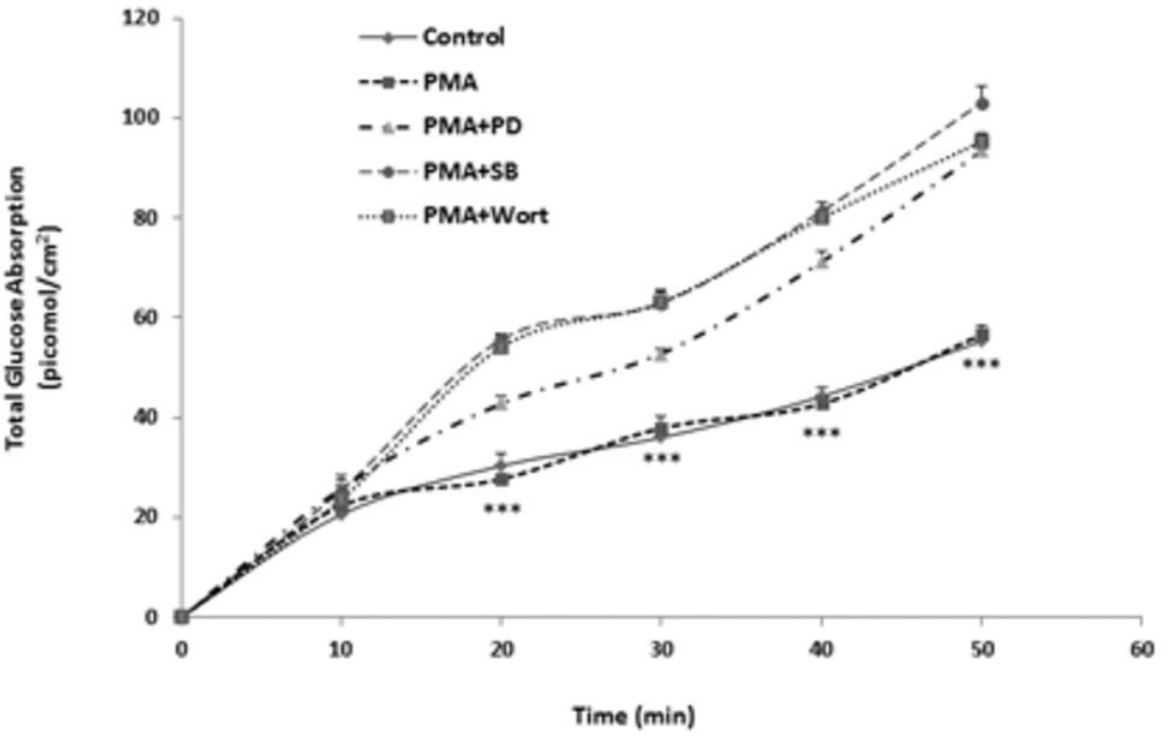
Figure 3. Effect of PKC activation with PMA in the individual presence of inhibitors of MEK/ERK (PD98059), or p38MAPK (SB202190) or PI3K (Wortmannin). Absorption of glucose was measured at 10-min intervals over a period of 50 min. Values are means ± SEM of 5 observations. ***P<0.001: significant difference from PMA + PD98059 as well as from PMA + SB202190 and PMA + Wortmannin. doi: